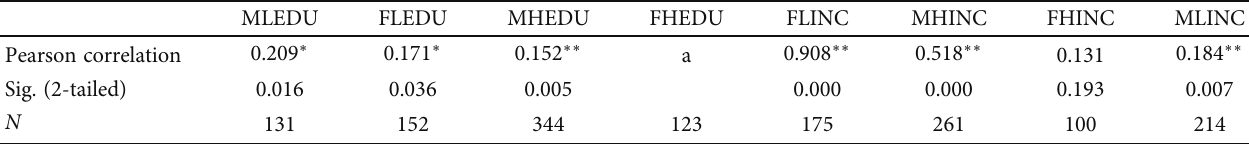
Table 7: Correlations of di ff erent combinations against WTP (source: authors).